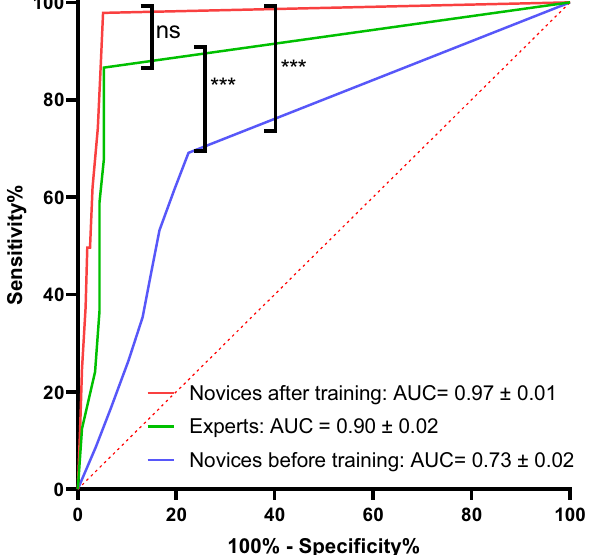
Figure 1. ROC curves in experts and in residents before and after training. ***p < 0.001, and ns not significant.